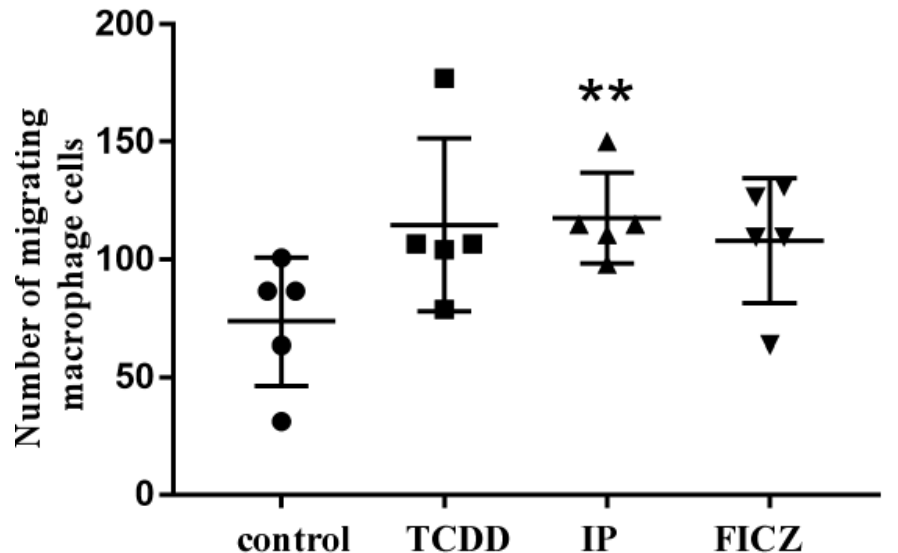
Figure 3. Migration of macrophage cells. In serum-free DMEM media with TCDD (10 − 8 M), IP (10 − 7 M) and FICZ (10 − 7 M), RAW 264.7 cells were cultured for 24 h, and images were taken. Crystal violet-stained cells take on a purple hue. The quantification of cells was performed as described above. The number of cells that migrated were totaled and presented as folds of increase compared to the control cells. Five independent experimental means ± SEM are represented in the graph. Unstimulated comparisons to control cultures were depicted by asterisks, such as. ** p < 0.01 by one-way ANOVA analysis.